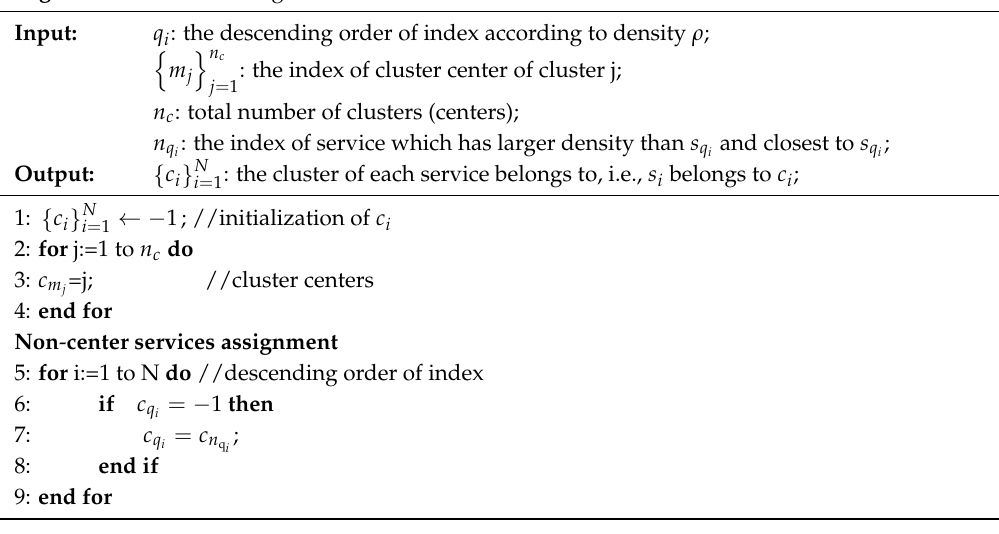
Algorithm 2. Cluster